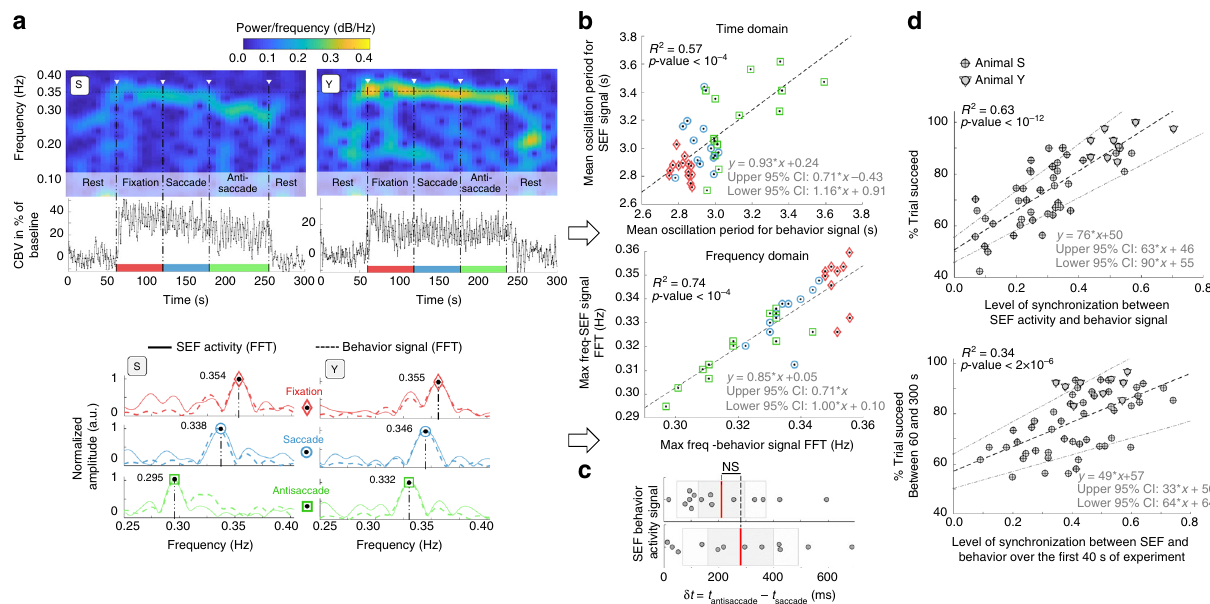
Fig. 3 Relationship between CBV oscillations, behavior and success rate. fUS imaging is able to differentiate the task response times for fi xation/saccade and antisaccade using frequency analysis of CBV changes in the SEF as well as the success rate. Panel a presents an example of two spectrograms related to CBV oscillations in the SEF (large ROI, ~240 pixels) for both animals (S and Y). During the visual task, the CBV in the SEF oscillates around 0.35 Hz and decreases during the rest phase. For each visual task, the fast Fourier transform of the temporal signal in the SEF and the related behavioral signal were plotted and superimposed. A match in peak frequency between the SEF signal and behavior signal indicates synchronization between brain activity and behavior. The behavior signal was created by plotting a sinusoid for which each period was de fi ned by the delay between trial start t i and t i + 1 , and as shown in Fig. 1c, this signal contains the response time of animals. b Whether in the time domain or frequency domain, there was a set of 13 acquisitions for which a signi fi cant correlation between CBV oscillations in the SEF and a related behavior signal was highlighted. c fUS imaging permitted the assessment of the subtle changes in task response time between the saccade and antisaccade experiments ( δ t = t antisacc – t sacc = 280 ± 210 ms) in agreement with behavior data ( δ t = 210 ± 160 ms, no signi fi cant difference, p = 0.36) using a limited set of 20 successive trials, raw data (gray circles) were summarized with mean (solid red line), 95% con fi dence interval (gray area), and one standard deviation (white area). d The correlation (level of synchronization) between the SEF signal and behavior signal has been plotted for all acquisitions and was signi fi cantly correlated to the success rate of the animal. It was even possible to predict the success rate of the animal only by considering the brain-behavior synchronization over the fi rst 40 s of the experiment. Coef fi cient correlation and p -value were computed using Pearson correlation between the no-rule and rule trials reveals a strong activation of the SEF region during the rule trials (Fig. 2a). The peak amplitude of the CBV signal increased in the SEF by 31.3% ± 15.2% on average over baseline in a large region of interest (ROI, ~240 pixels) and 84.8% ± 38.7% in a 1-pixel ROI in all 85 recorded sessions (similar results were obtained in ROI of 6 and 12 pixels, but for more clarity data were not shown). In the large and 1- pixel control regions, the average variation and the standard deviation were 8.8% ± 10.9% and 8.7% ± 21.6%, respectively (Fig. 2b). fUS could detect a rule change from the single fi rst trial . The high sensitivity of the technique also allows fast CBV dynamics during rule change from the single fi rst trial to be detected. CBV